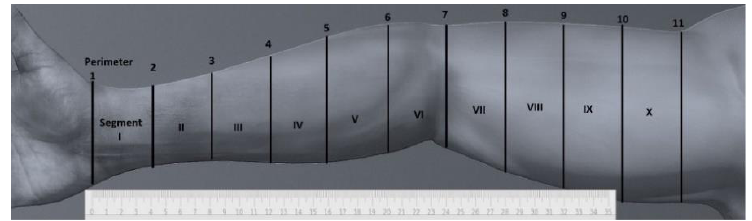
Figure 1. Locations of the perimeter measurements and the resulting segments.